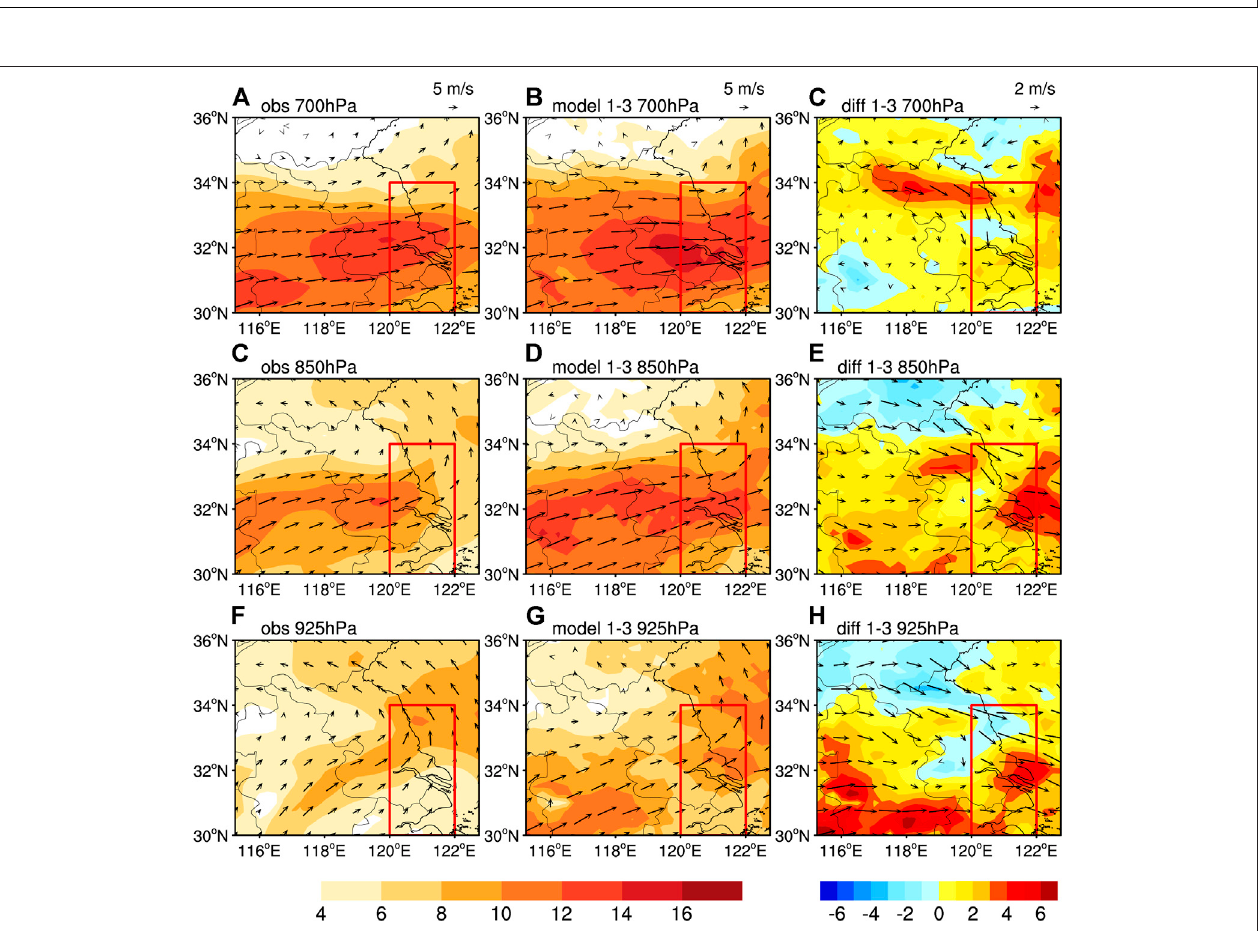
FIGURE7| Compositesofwind fi elds(arrow, m/s )duringWRWSoccurrencemomentsinobservations (A,D,G) andthePWAFS forecasts (B,E,H) ,aswellastheir differences (C,F,I) , at 700 hPa (A,B,C) , 850 hPa (D,E,F) , and 925 hPa (G,H,I) . The shading represents the full wind velocity ( m/s ).